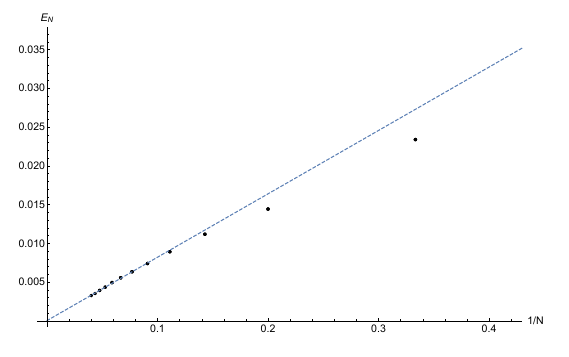
Figure 5 . Plot of E N for as a function of 1 =N , c = 8, (cid:1) (cid:30) = 7 curve is a linear (cid:12)t for N